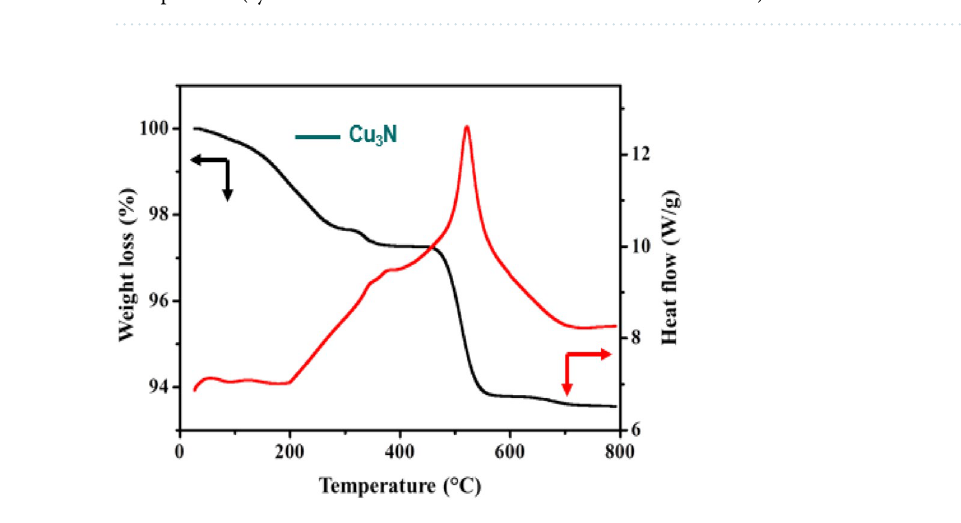
Figure 8. TGA/DSC analysis of the synthesized Cu 3 N at 160 ml/min ammonia flow rate and 300 °C.